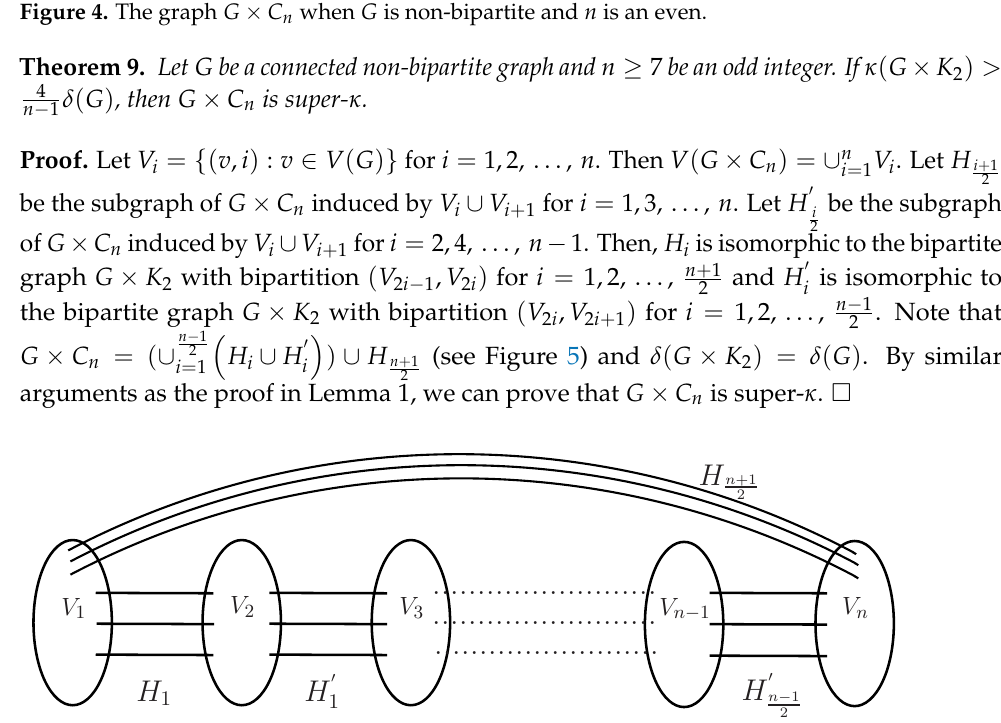
C n when G is non-bipartite and n is ×